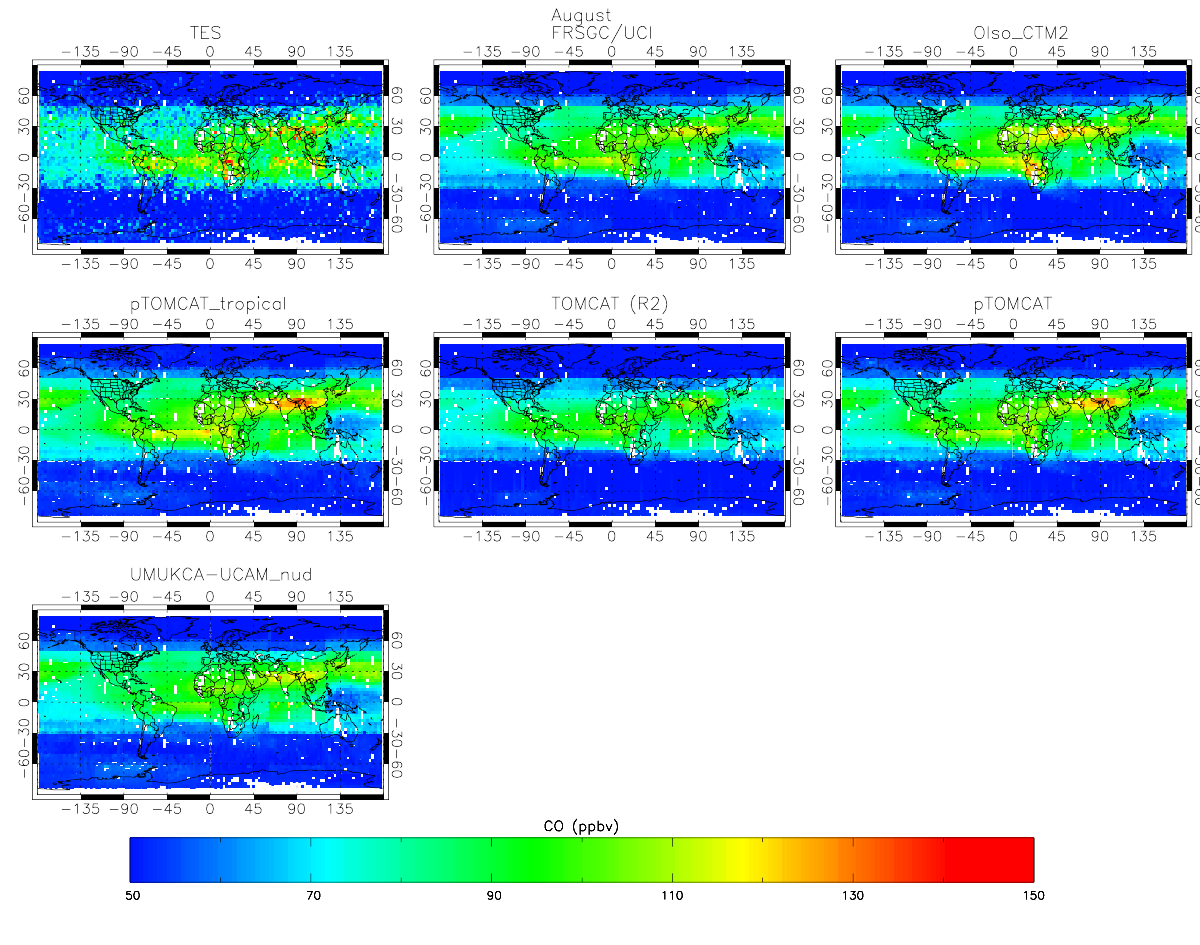
Fig. 15. As in Fig. 11, but for 195hPa and August